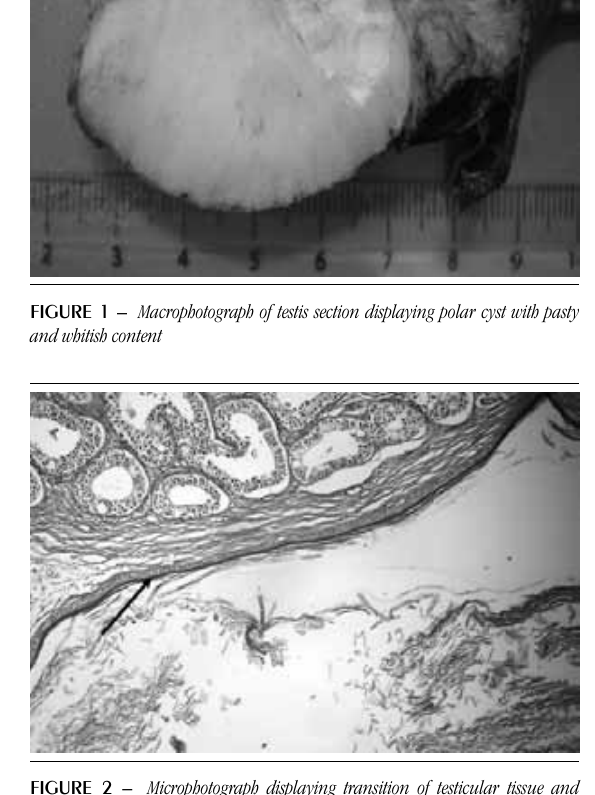
figurE 4 – Section of ovarian wall including corpus albicans (arrow) and squamous-lined cyst to the right (HE, 100×) HE: hematoxylin and eosin.